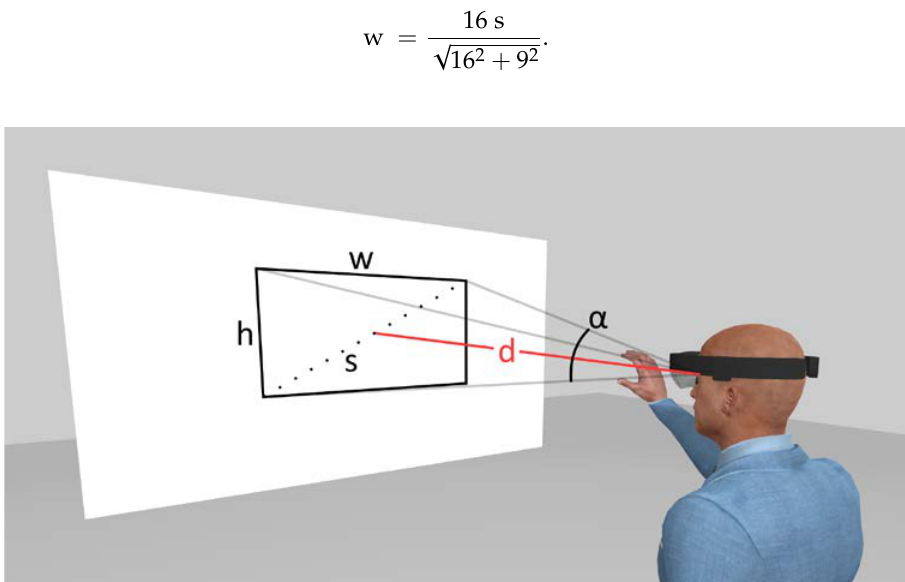
Figure 3. Schematic representation of the Microsoft HoloLens diagonal field of view (35°) and aspect ratio (16:9), and the relative visible area at a distance of 2.0 m in front of the user.